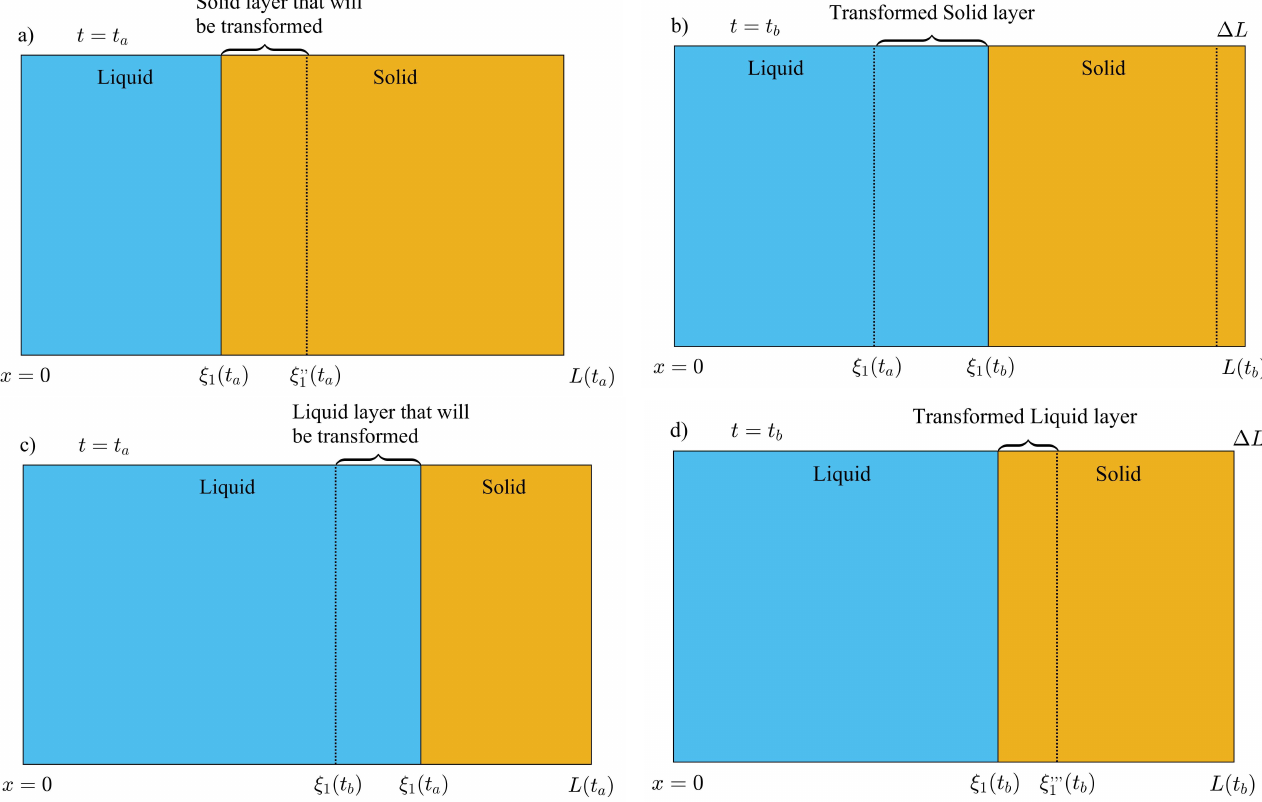
Figure 7. Volume changes during melting and solidification in a PCM layer with a two phase configuration (one-front). ( a ) Saturated solid layer in direct contact with ξ 1 ( t a ) that will transform into its liquid phase. ( b ) Transformed solid layer during the melting process between t a and t b . ( c ) Liquid layer at some time t = t a that will change to its solid phase. ( d ) Transformed liquid layer in contact with ξ 1 ( t b ) after the phase